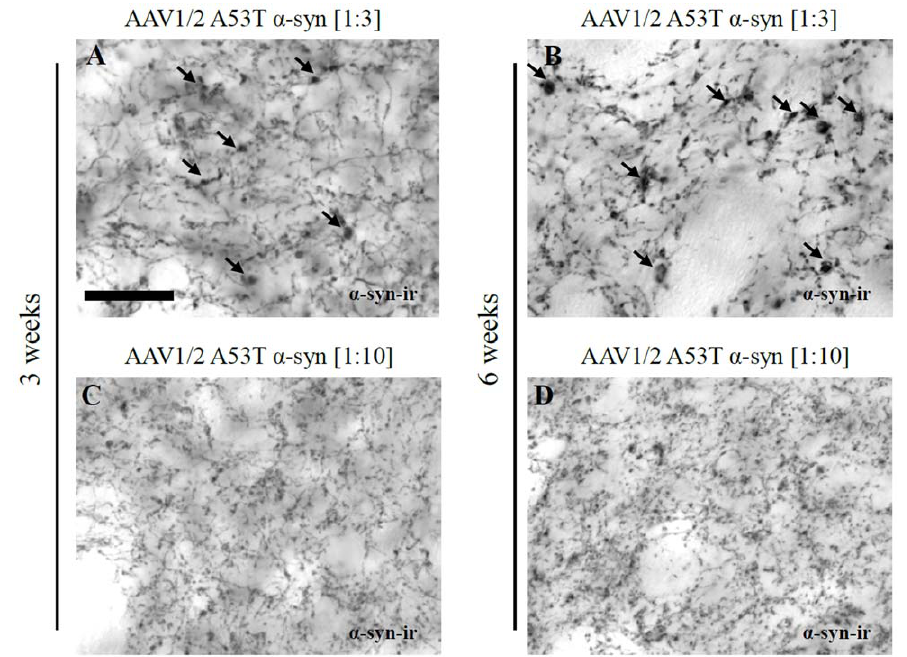
Figure 5. Dystrophic axon morphology in rats injected with AAV1/2 A53T a -synuclein. Delivery of AAV1/2 A53T alpha-synuclein (1:3, 1.7 6 10 12 gp/ml) to the substantia nigra produces dystrophic and bulging neurites in the striatum 3 and 6 weeks later with increasing severity (A,B). Injection of the 1:10 dilution (1:10, 5.1 6 10 11 gp/ml) of AAV1/2 AAV1/2 A53T a -syn also showed signs of abnormal axonal architecture, although not to the same degree (C,D). Arrows point to evidence of human alpha-synuclein positive dystrophic neurites; scale bar is 50 m m. doi:10.1371/journal.pone.0017698.g005 behaviour. As the disease model progresses to the six week apparent (DA neuron loss in SN and reduced striatal DA). timepoint, however, fibers are increasingly lost (measured by TH and DAT) and the prototypical nigrostriatal pathology becomes